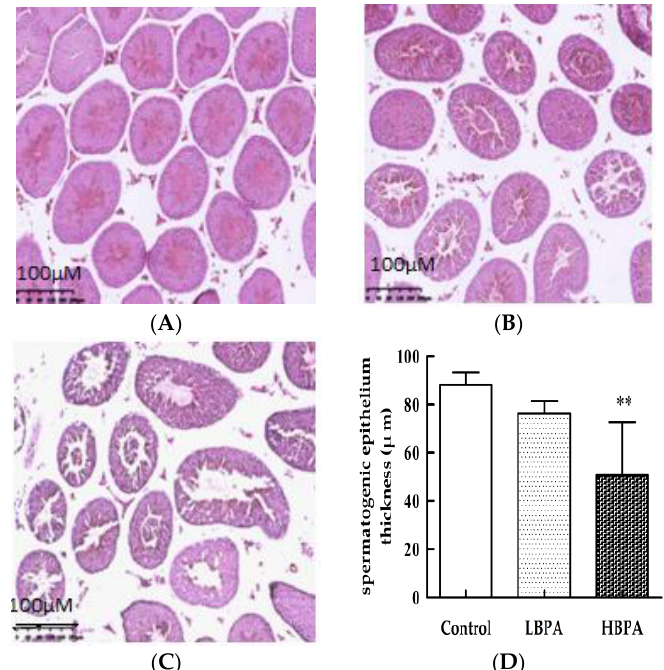
Figure 5. Effects of perinatal BPA exposure on pathological damage in the testis tissue of male offspring. Histology of control mice ( A ), 0.2 μg/mL BPA ( B ), and 2 μg/mL BPA ( C ). Semi-quantitative analysis of testicular spermatogenic epithelium thickness by hematoxylin and eosin (H&E) staining ( D ). ** p < 0.01 compared with controls. Magnification: A – C , 200×.